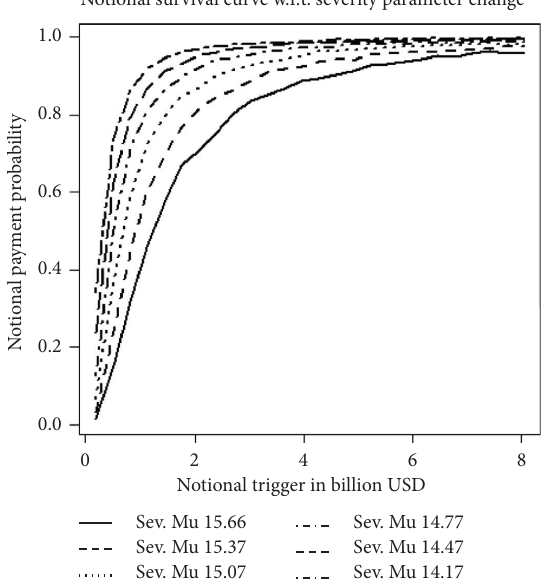
Figure 29: Cyber bond notional survival curve for 3years for μ in the interval μ ± μ · 5%.